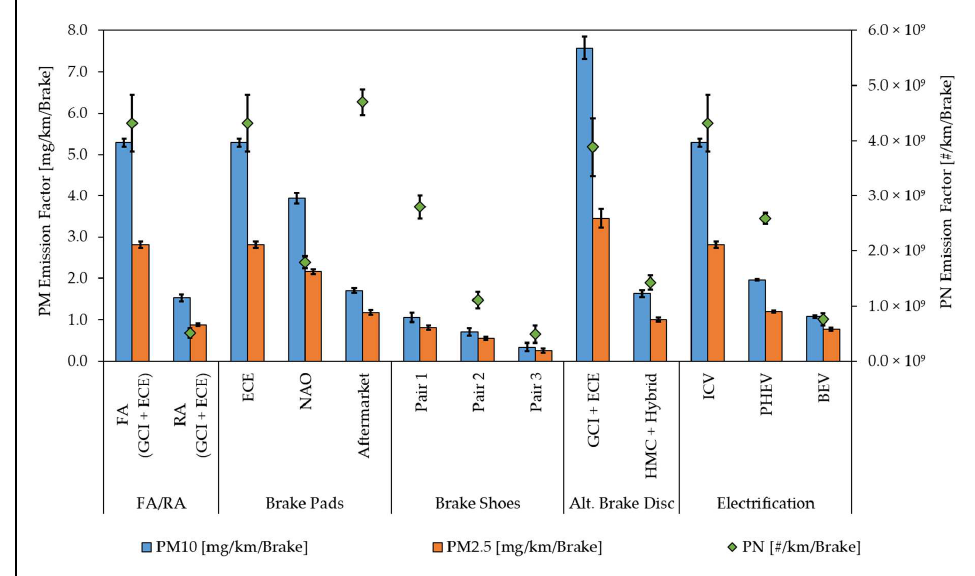
Figure 18. Overview of reported emission factors and their measurement